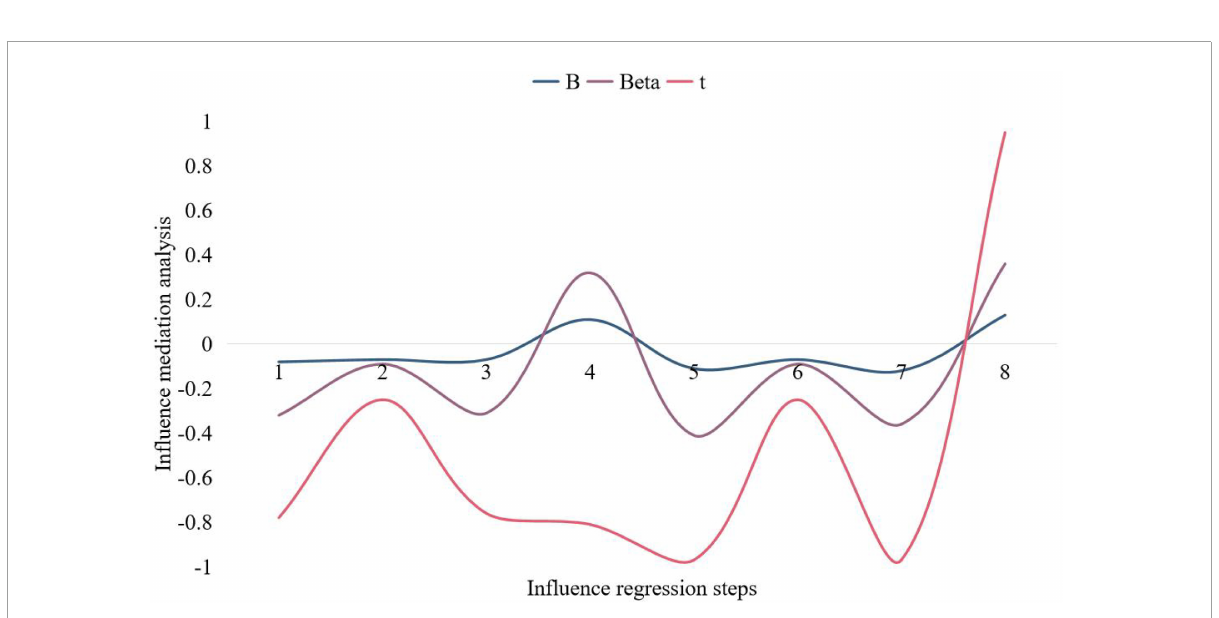
FIGURE8 Mediation analysis of the effect of